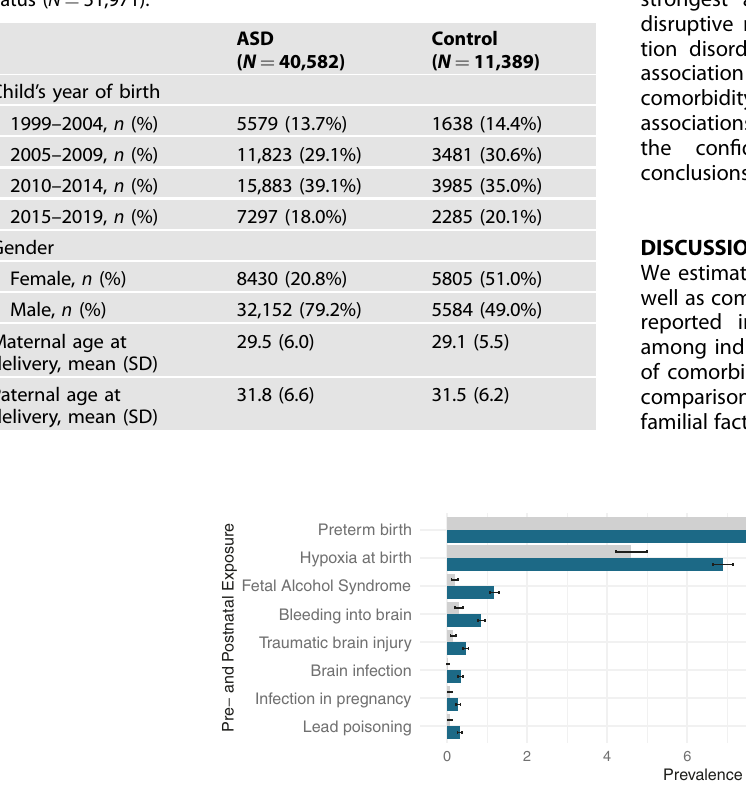
Table 1. Demographic characteristics of the analytical sample by ASD status ( N = 51,971).